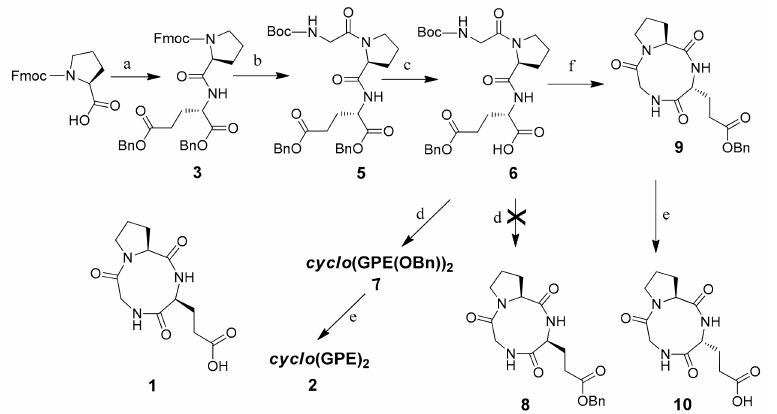
Scheme 1. Synthesis of cyclo (GPE) 2 and cyclo (GP D E). ( a ) Dibenzyl L -glutamate p -toluenesulphonate, DCC, HOBt, TEA, DCM, 0 ◦ C~rt ( b ) (i) 20% piperidine in DCM, rt (ii) Boc-Gly-OH, DCC, HOBt, TEA,